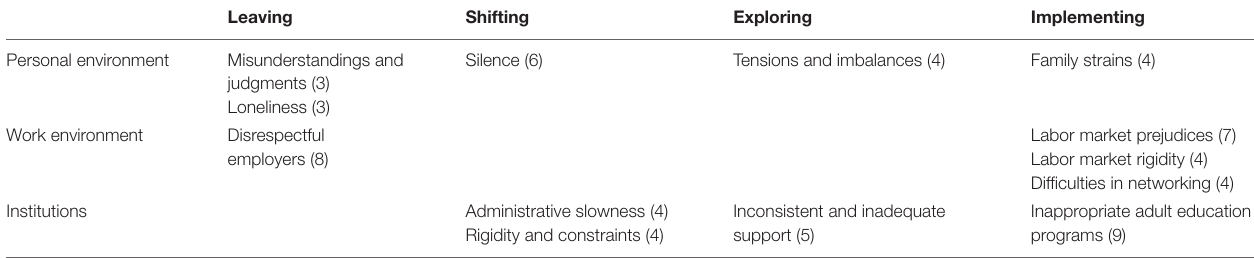
TABLE 3 | Subthemes within negative relational influences. Leaving